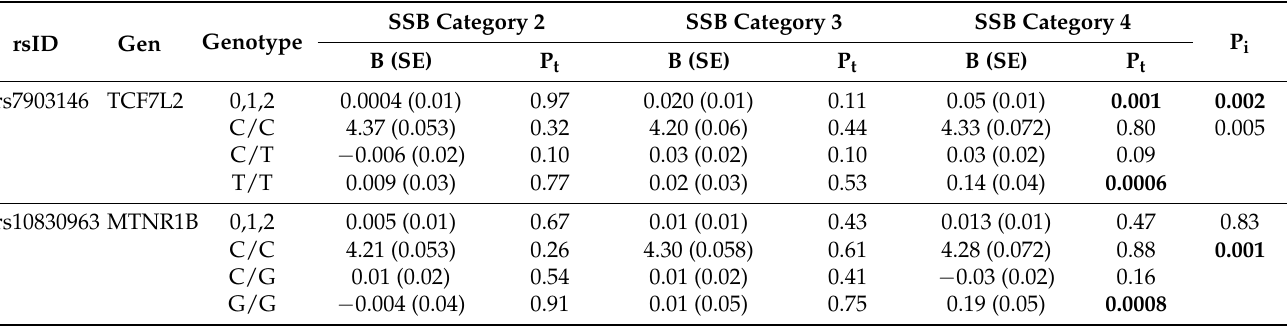
Table 2. Interaction between rs7903146 and rs10830963 (as continuous and categorical variable) and levels of SSB categories intake on log-fasting